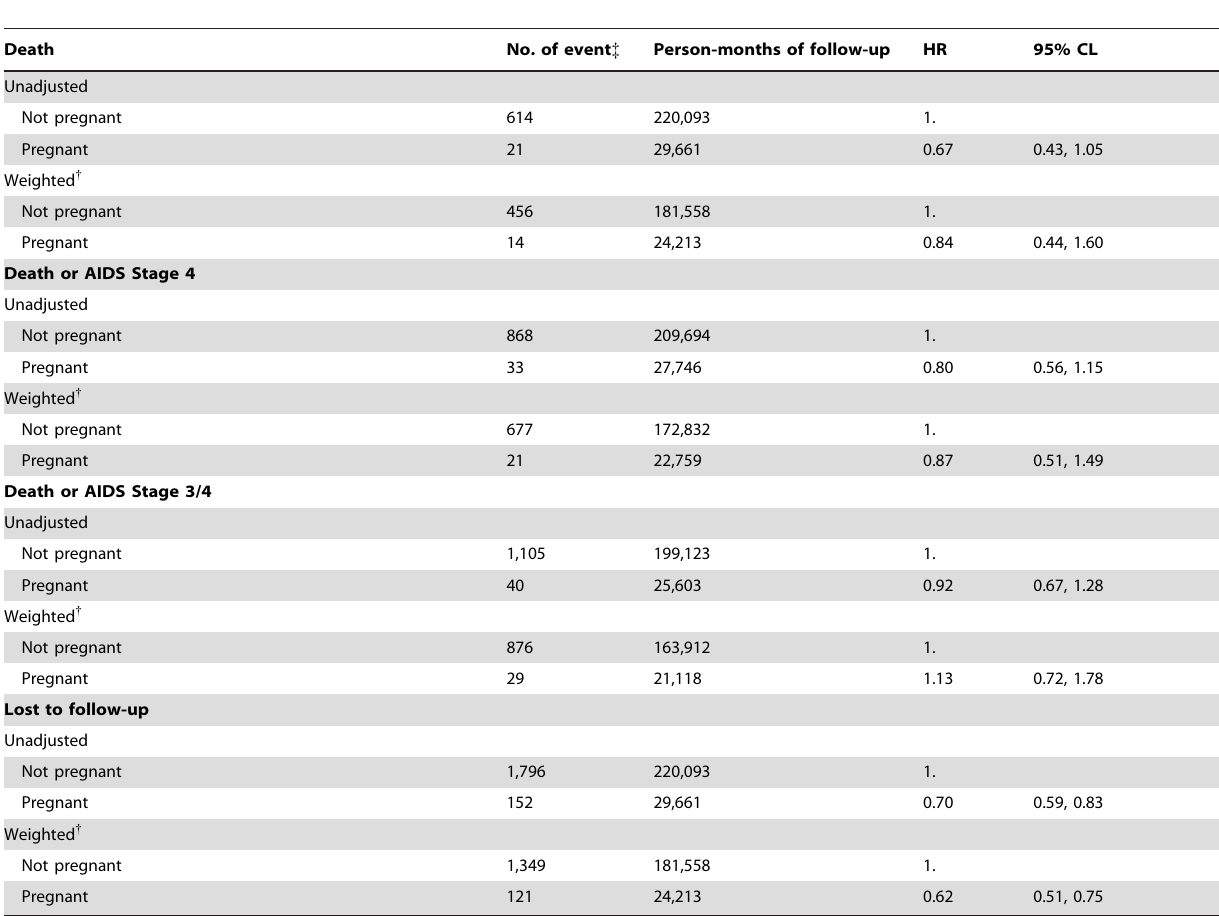
Table 2. Estimated effect of pregnancy on time to death and alternate outcomes among 7,534 women initiating HAART in South Africa,